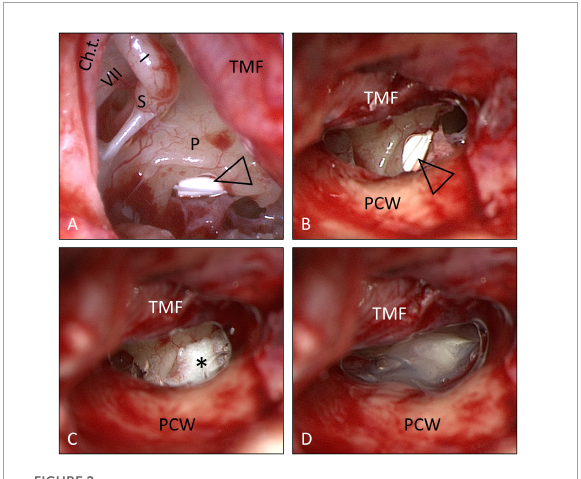
FIGURE2 Surgical procedure (same patient as in Figure 1 ): Placement of the solid, biodegradable drug delivery system onto the RWM. (A,B) Implant pieces (open triangle) in situ . The implants were then covered with soft tissue (*) (C) , which was secured in places with fibrin glue (D) . See also Supplementary video material . Ch.t.: Chorda tympani; I: long process of incus; P: promontory; PCW: posterior canal wall; S: stapes head; TMF: tympanomeatal flap; VII: facial nerve. (A) Endoscopic view: 30 ◦ , 1.7 mm. Figure (A) after Plontke (2018) with permission.